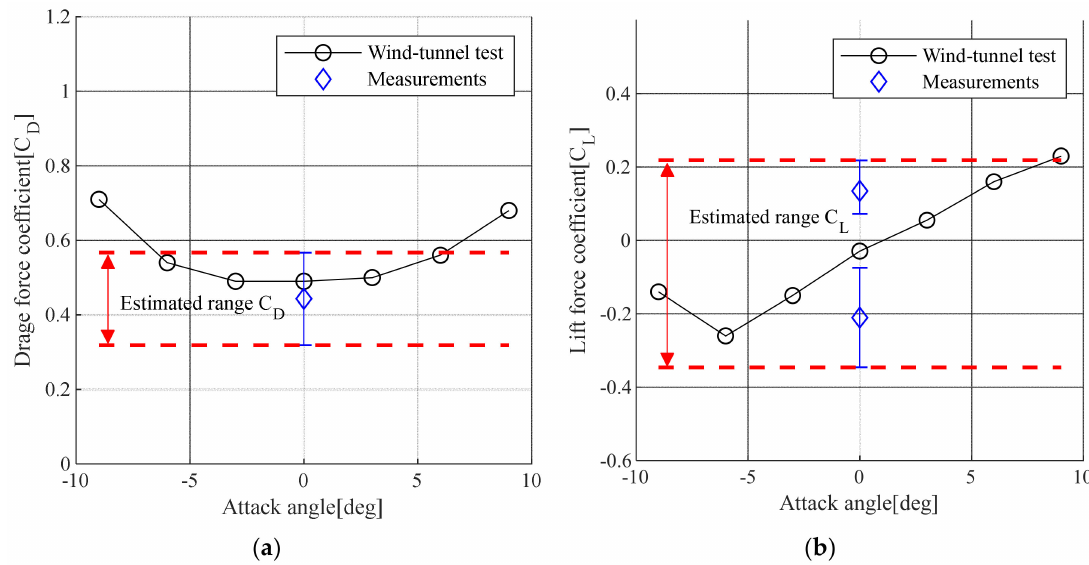
Figure 7. Comparison of estimated values for the drag and lift coe ffi cients: ( a ) Drag force coe ffi cient (C D ); ( b ) Lift force coe ffi cient (C L